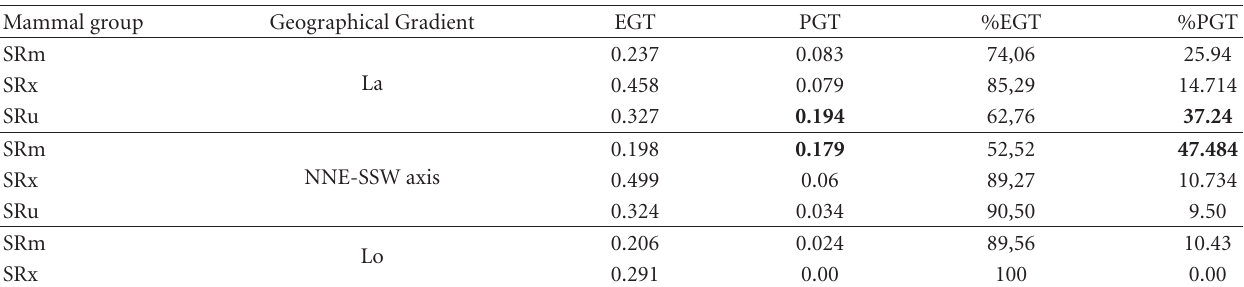
Table 7: Variation partitioning of species richness (SR). The shown values are the proportion of variation in SR corresponding to a geographical trend attributable to environmental causes (EGT), the proportion corresponding to a pure geographic trend (PGT), the percentage of the total geographical trend environmentally explained (% EGT) and the percentage of the geographic trend attributable to a pure geographic e ff ect (% PGT). Variable codes as in Table 1 and Figure 2. In bold are the values corresponding to pure geographic trends that are significant according to the partial correlation